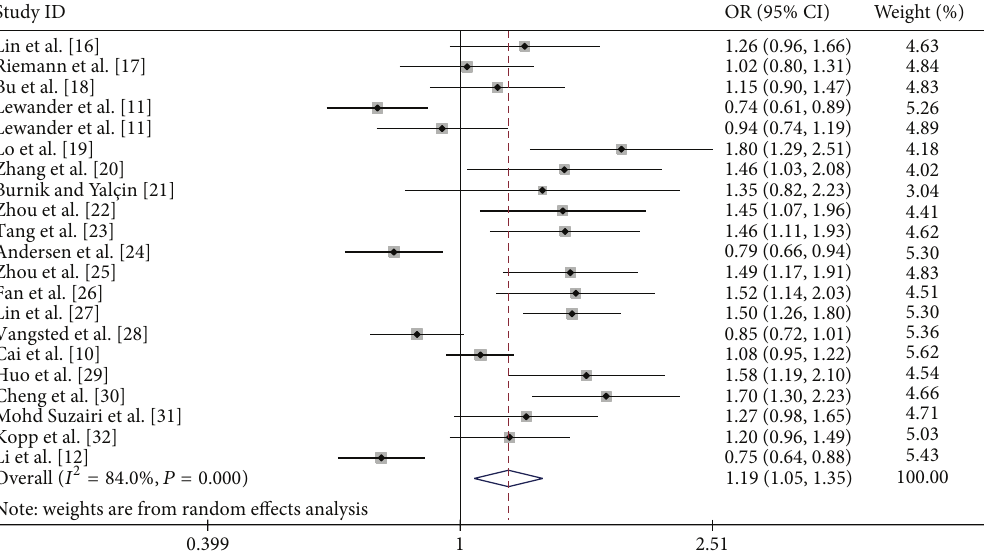
Figure 2: Forest plot of cancer risk associated with NFKB1 promoter − 94ins/del ATTG polymorphism (for insertion allele versus deletion allele) among all studies.